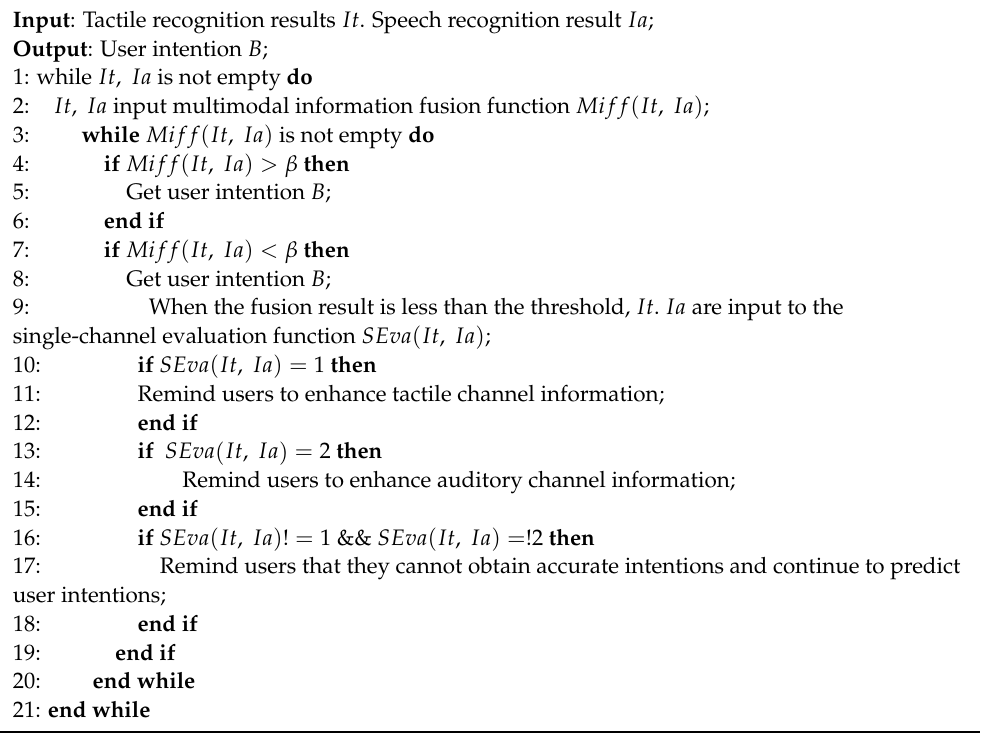
Algorithm 1 Multimodal intention active understanding algorithm